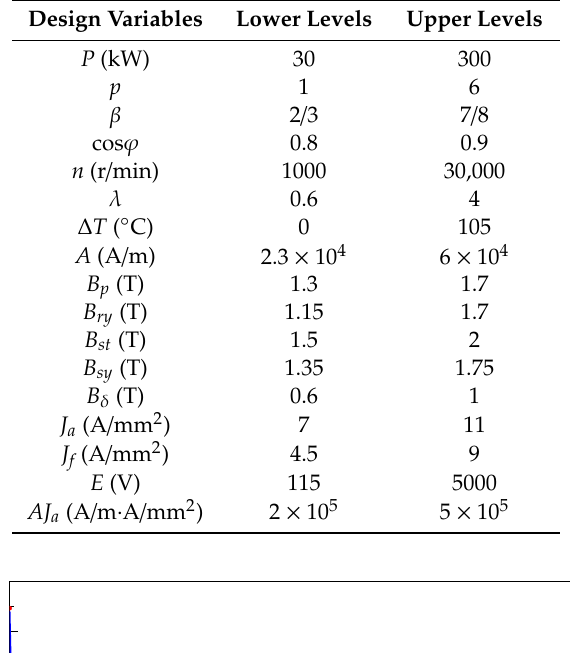
Table 1. Variation ranges of the built generator model.